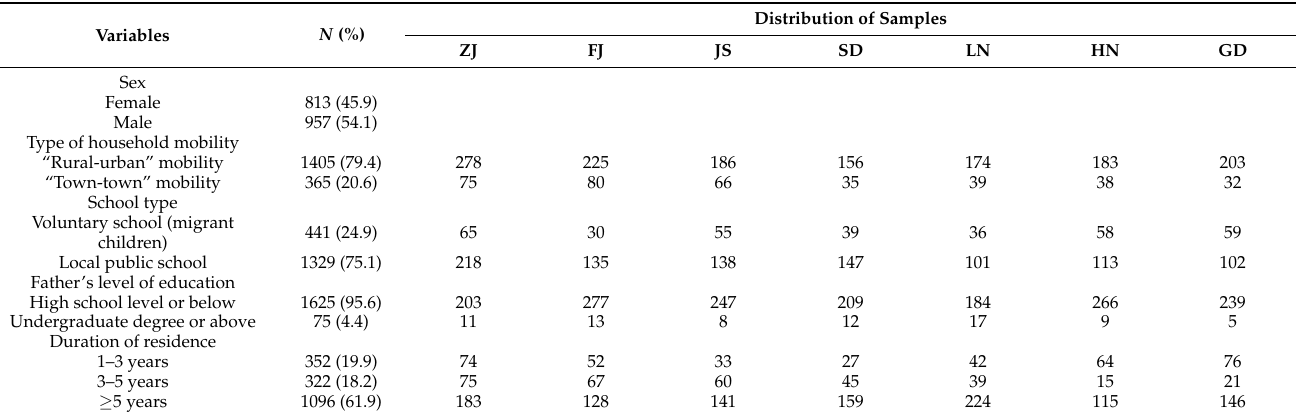
Table 1. Demographic information of the sample.